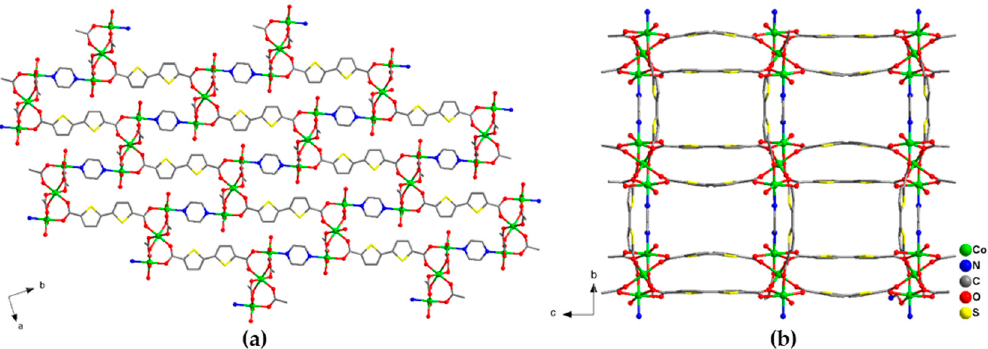
Figure 3. Projection of the crystal structure of 2 along different directions. Cobalt atoms are shown by green balls. Only O atoms of coordinated dmf ligands are shown. Hydrogen atoms and guest solvent molecules are not shown.